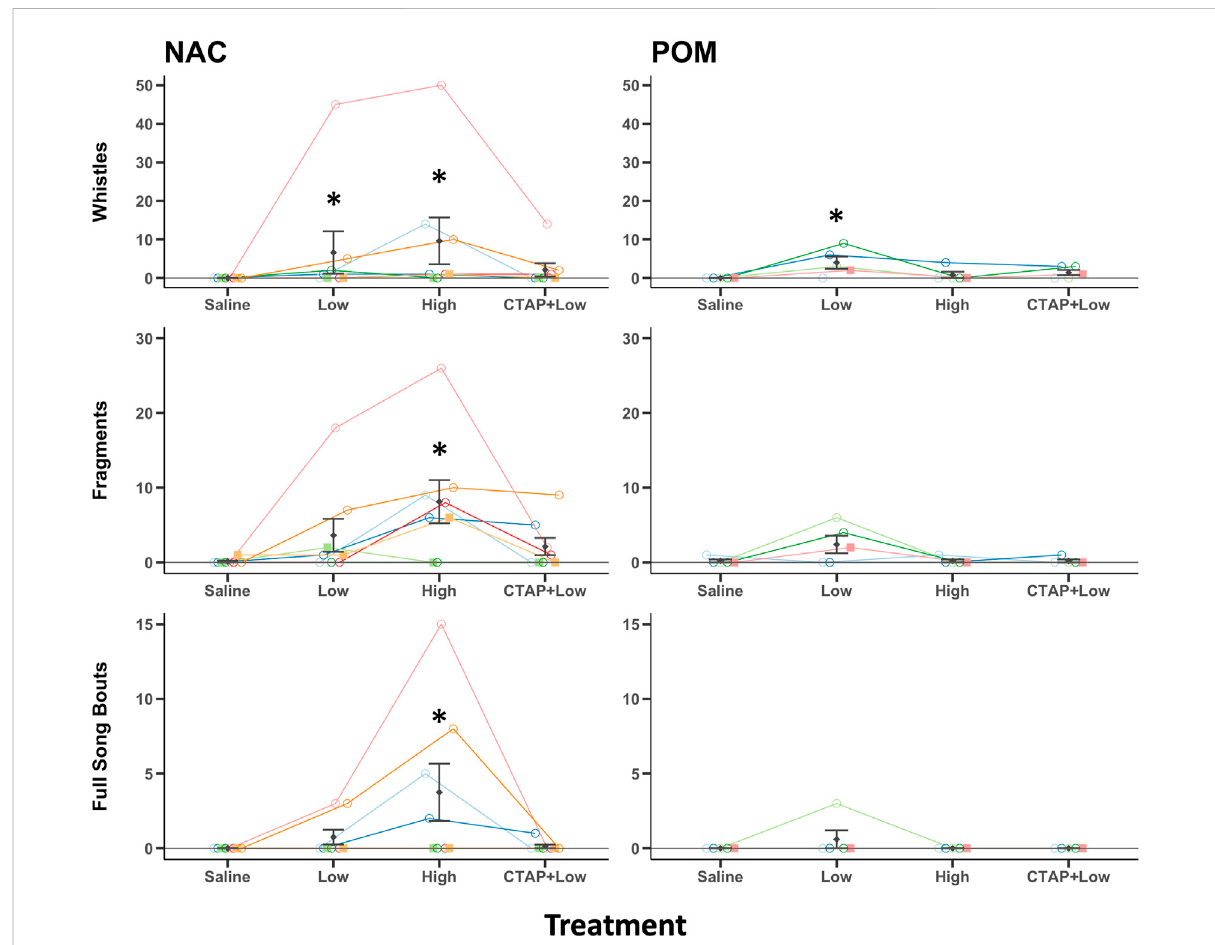
FIGURE 3 MORstimulationinNACorPOMfacilitatessingingbehaviors.EffectsofintraNACandintraPOMtreatmentsofSaline,lowdoseDAMGO(2.5 μ g; Low), high dose DAMGO (25 μ g; High) and the MOR antagonist CTAP followed by low dose DAMGO (CTAP + Low) on introductory whistles, song fragments, andfullsongbouts.Note:becausewhistlerateswerelowinsomebirds,theyarejustvisibleabovethe0line;however, forNAC0/8saline treatedbirds,4/8lowdoseDAMGOtreatedbirds,6/8highdoseDAMGOtreatedbirds,and3/8CTAP+DAMGOtreatedbirdswhistled.ForPOM the results were 0/5, 4/5, 1/5, and 3/5, respectively. Mean ± sem is indicated for each group. Individual repeated data points are shown for males (circles) and females (squares). * indicates p < 0.05 compared to saline. See results for additional statistical